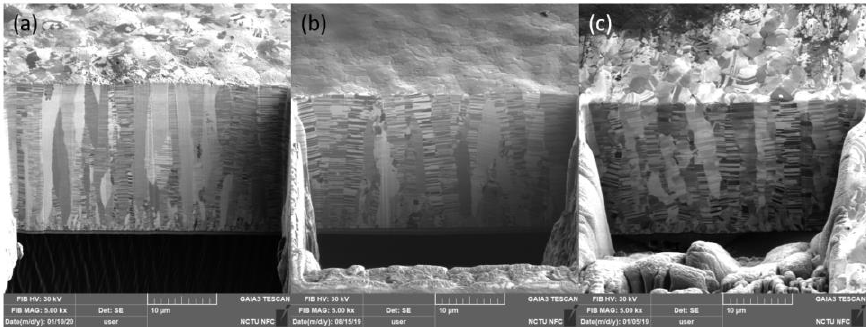
Figure 3. Cross-sectional ion images of ( a ) type-A, ( b ) type-B, and ( c ) type-C nt-Cu foils.